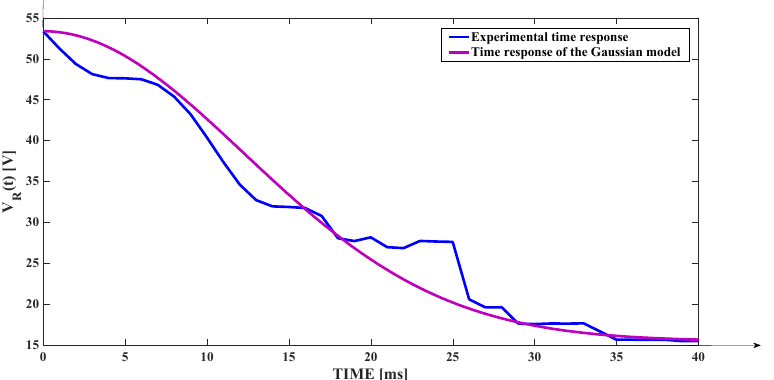
Figure 14. Comparative graph between the experimental response and the response of the Gaussian model.